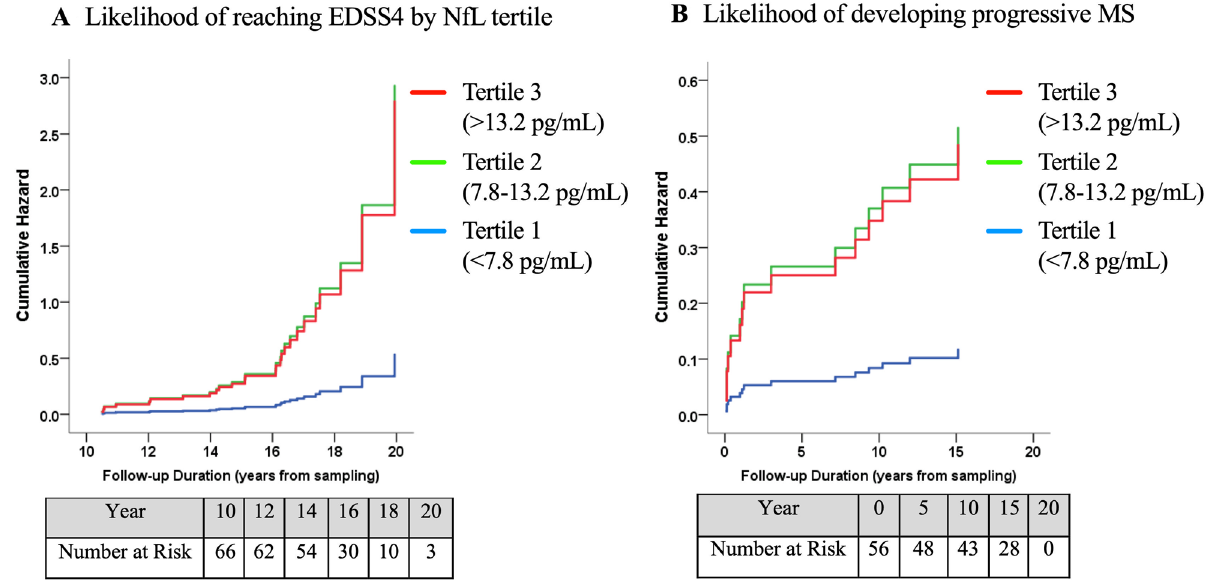
Figure 6. NfL tertile and likelihood of clinical progression. Kaplan–Meier survival curves to compare hazard of progression to EDSS ≥ 4 ( A ) (Cox regression overall p = 0.012 df 2 Chi-square 8.9) and conversion to SPMS ( B ) (Cox regression overall p = 0.0113 df 2 Chi-square 4.4) after long-term follow-up in subgroups of MS patients based on serum NfL tertiles at